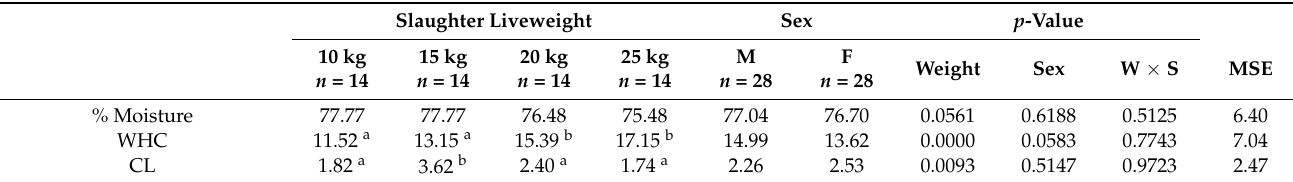
Table 3. Means and mean square errors of moisture, WHC and cooking loss of LT muscle in the four weight groups and in male and female groups.